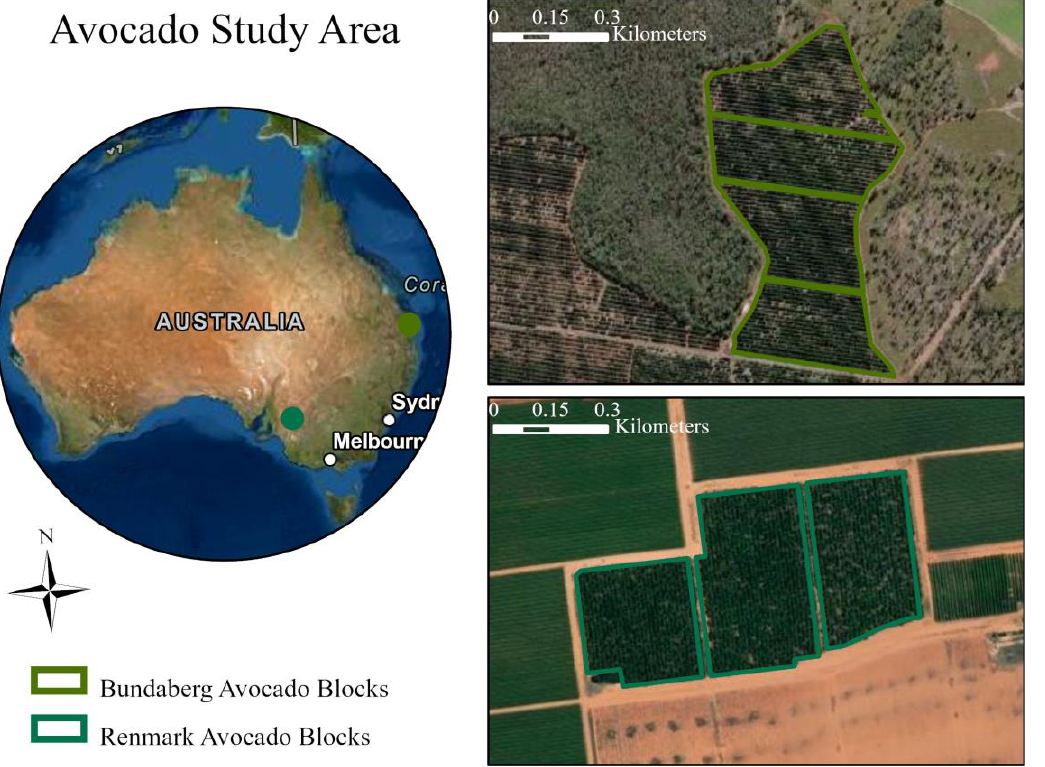
Figure 1. Locations of the four avocado blocks in Bundaberg, Queensland and the three avocado blocks in Renmark, South